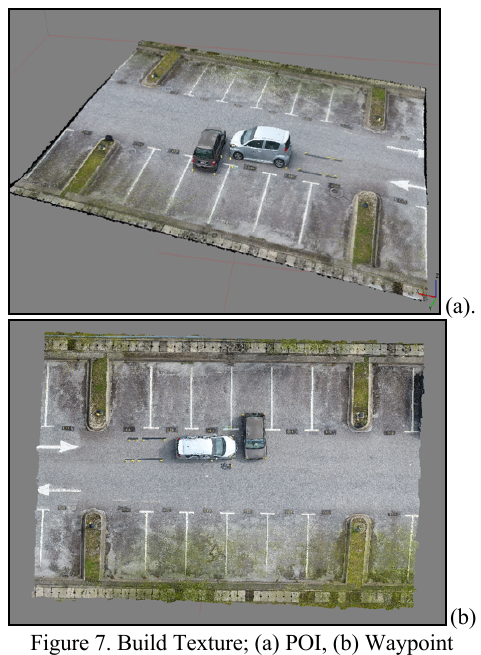
Figure 7. Build Texture; (a) POI, (b) Waypoint